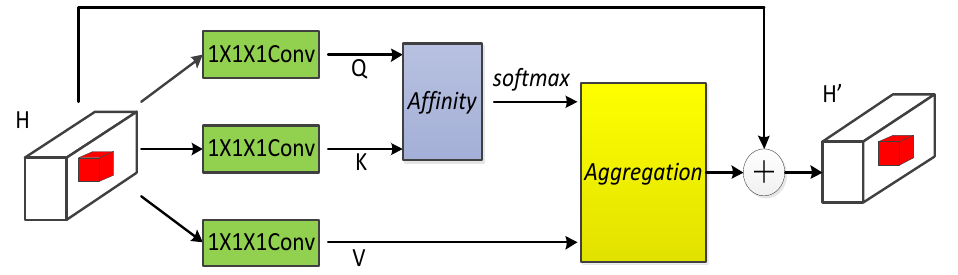
Figure 6. Cross-attention model. Q, K, and V are all extracted feature graphs.